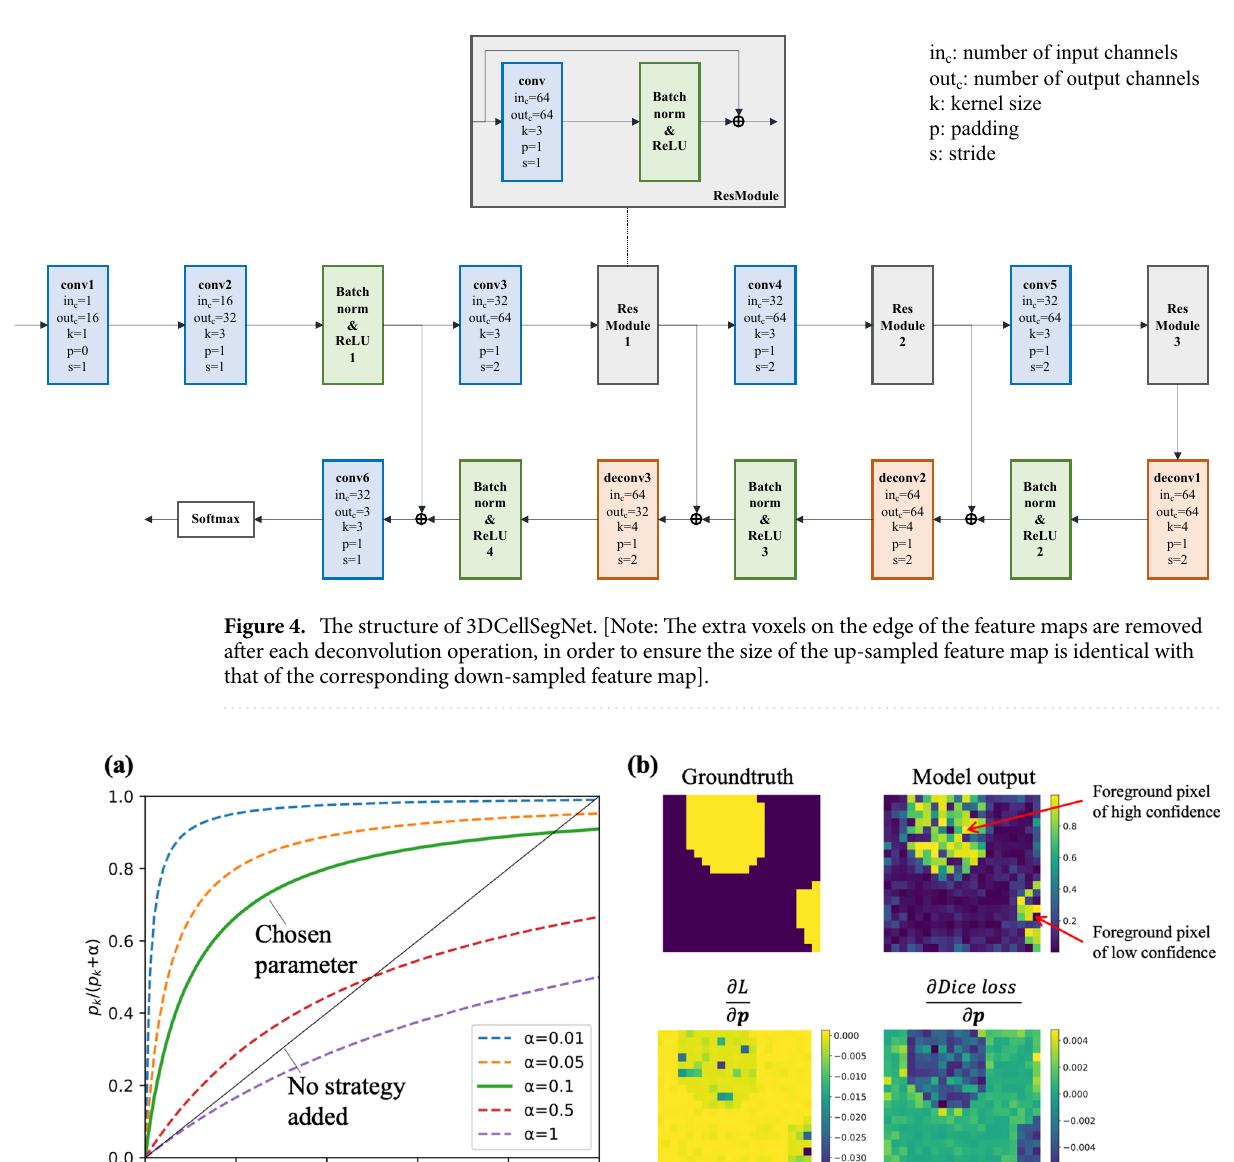
vs p k at different α values k + α